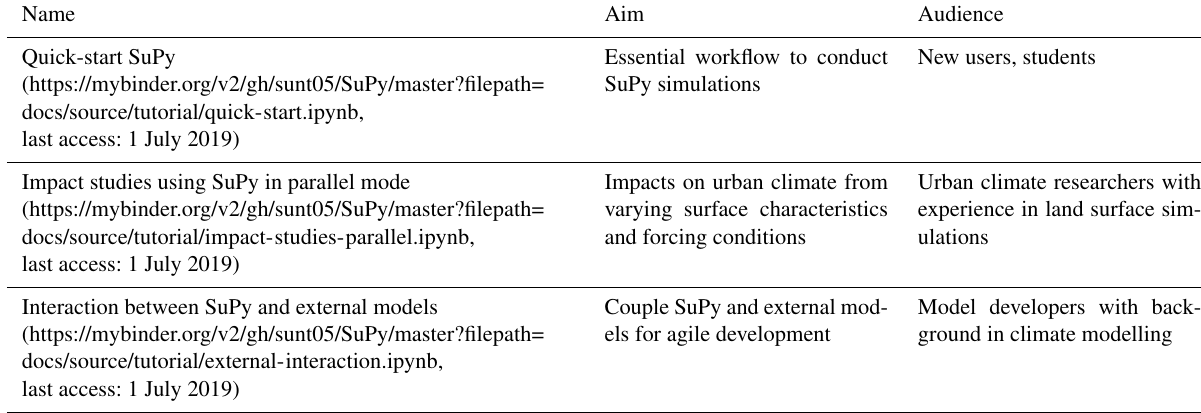
Table 2. Three SuPy tutorials. Note that the website links redirect to online Jupyter notebooks for SuPy simulation without any configuration by users.